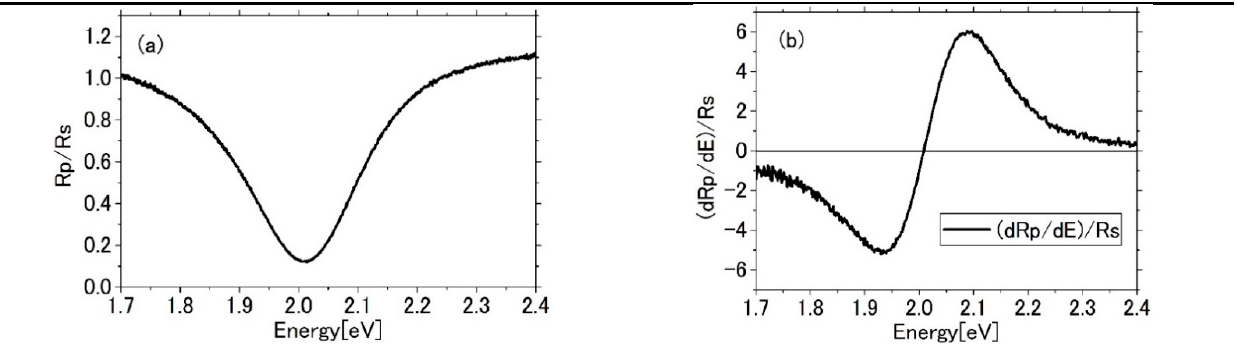
Figure 4. ( a ) Reflection spectrum and ( b ) its first derivative with respect to the photon energy, measured with the cooled spectrometric CCD.